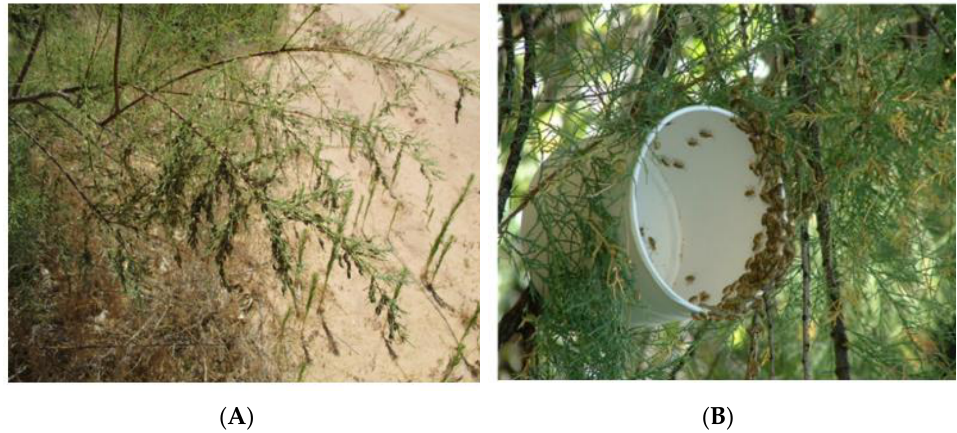
Figure 2. ( A ) Aggregation of Diorhabda carinulata on Tamarix . ( B ) A field release of D. carinulata from a cardboard container, typical for insect biocontrol releases.